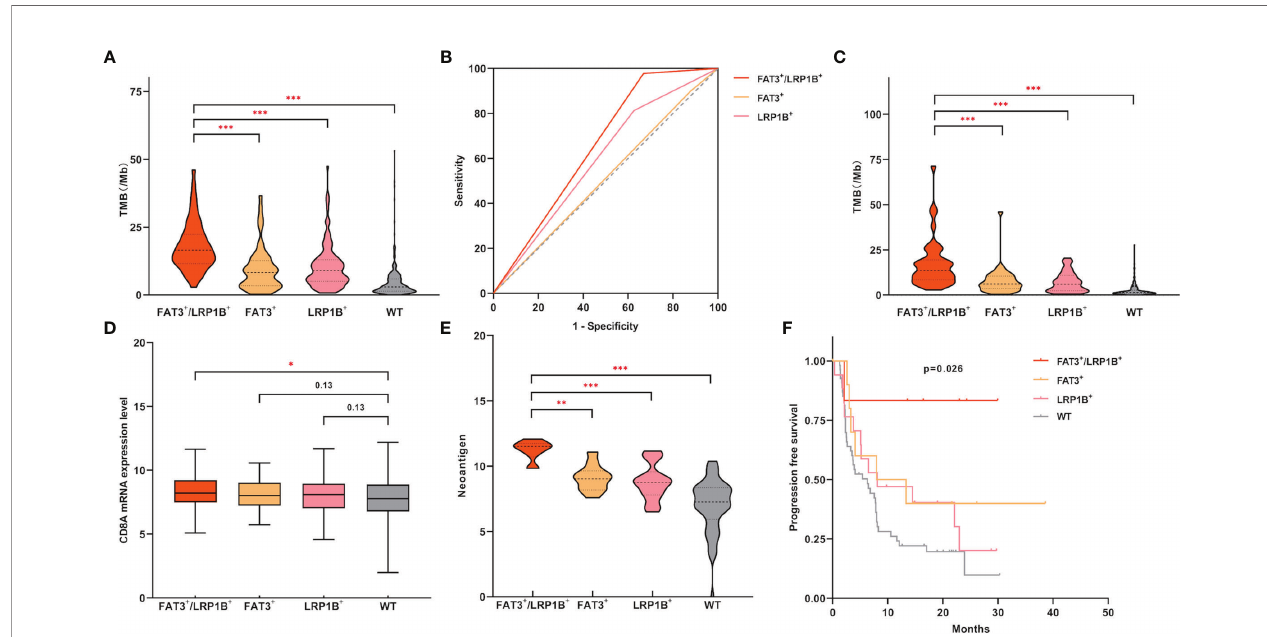
FIGURE 4 | LUAD samples with FAT3 and LRP1B co-mutation had signi fi cantly higher TMB levels and exhibited unique immune characteristics. (A) Compared with LUADs with only FAT3 or LRP1B mutations alone, the LUAD subgroup with co-mutation of FAT3 and LRP1B had signi fi cantly higher TMB level. (B) High speci fi city of FAT3 and LRP1B co-mutation status for predicting TMB-H (>10 mutations/Mb). The prediction performance of the FAT3 + /LRP1B + group for TMB-H exceeded that of the FAT3 + and LRP1B + groups, with an AUC of 0.655, a 95% con fi dence interval of 0.596-0.713, and p<0.001. (C) The validation cohort of 485 LUAD samples con fi rmed the FAT3 + /LRP1B + group had the highest TMB level. (D) Compared with wild-type samples, LUADs in the FAT3 + /LRP1B + group had signi fi cantly higher CD8A mRNA expression level (adding one pseudo-count and log 2 transformation). (E) The level of neoantigen (adding one pseudo-count and log2 transformation) in the FAT3 + /LRP1B + group was higher than that in the FAT3 + and LRP1B + groups. (F) The immunotherapy PFS of the FAT3 + /LRP1B + group was signi fi cantly prolonged. Statistical comparisons between different groups were made by Mann-Whitney test (A, C – E) , and survival curves were plotted using the Kaplan-Meier method and compared by the log-rank test (F) . *p < 0.05, **p < 0.01, ***p <